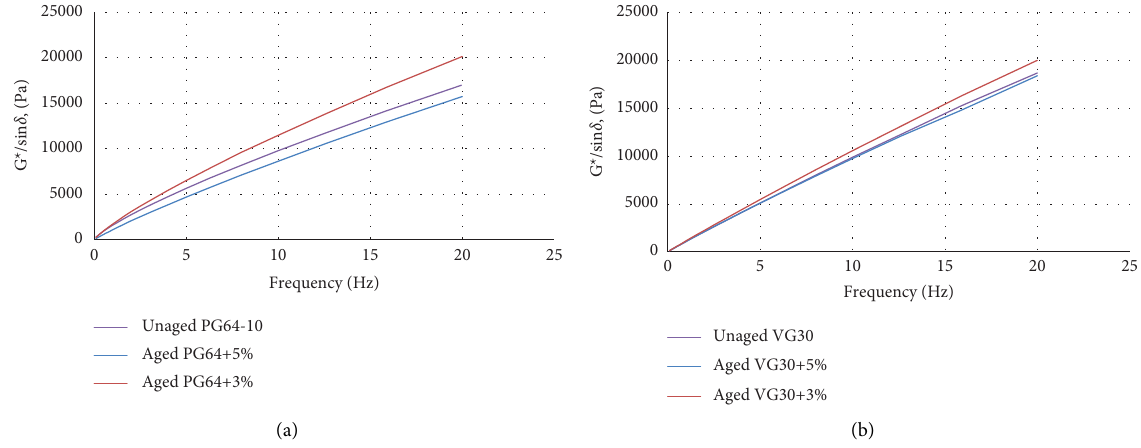
Figure 5: Variation of rutting parameters as a function of frequency: (a) PG 64-10; (b) VG30.